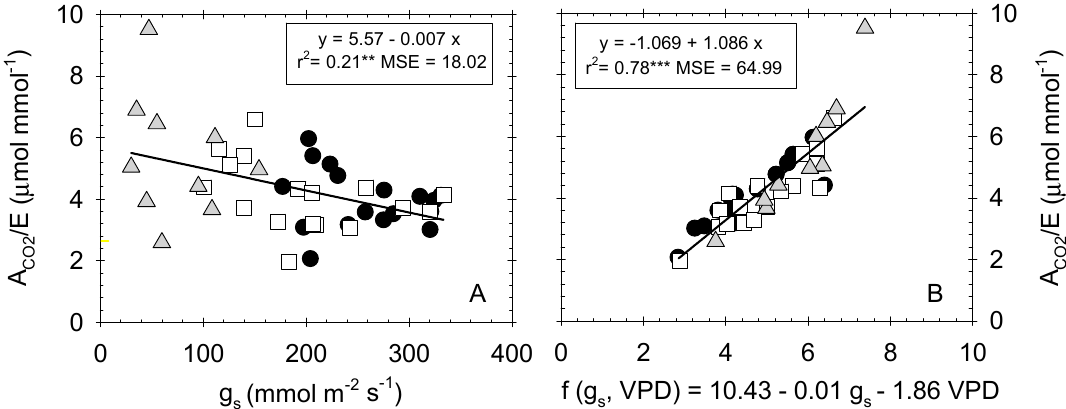
Figure 6. Relationship between ( A ) stomatal conductance (g s , mmol m − 2 s − 1 ) and instantaneous water-use e ffi ciency (A CO2 / E, µ mol mmol − 1 ); and ( B ) the two-variable function (g s , VPD) and A CO2 / E in the different irrigation treatments: T–C ( ● ), T–M ( □ ), and T–S ( ). Each point is the mean of 4 leaves. Coe ffi cient of determination in ( A ): T–C (r 2 = 0.05 ns), T–S (r 2 = 0.15 ns), T–S (r 2 = 0. 06 ns); and